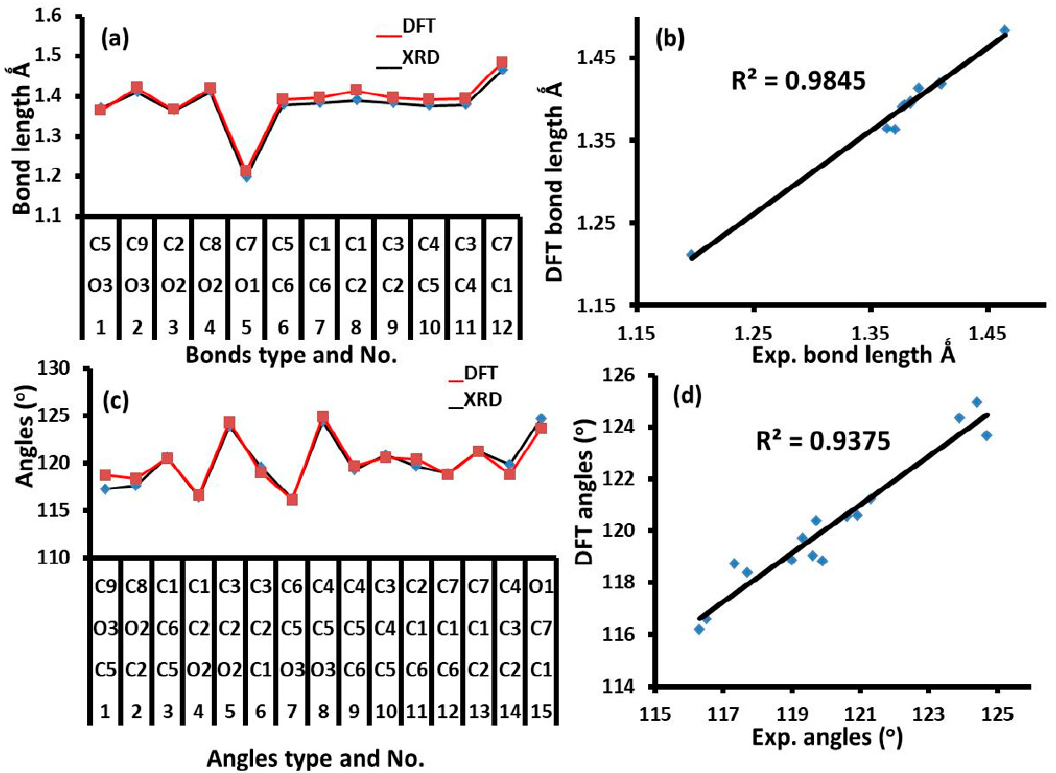
Figure 2. Histograms of ( a ) bond lengths and ( c ) angles determined by X-ray diffraction (XRD) and density functional theory (DFT). ( b ) and ( d ) Graphical correlations of the bond lengths and angles determined by XRD and DFT, respectively.